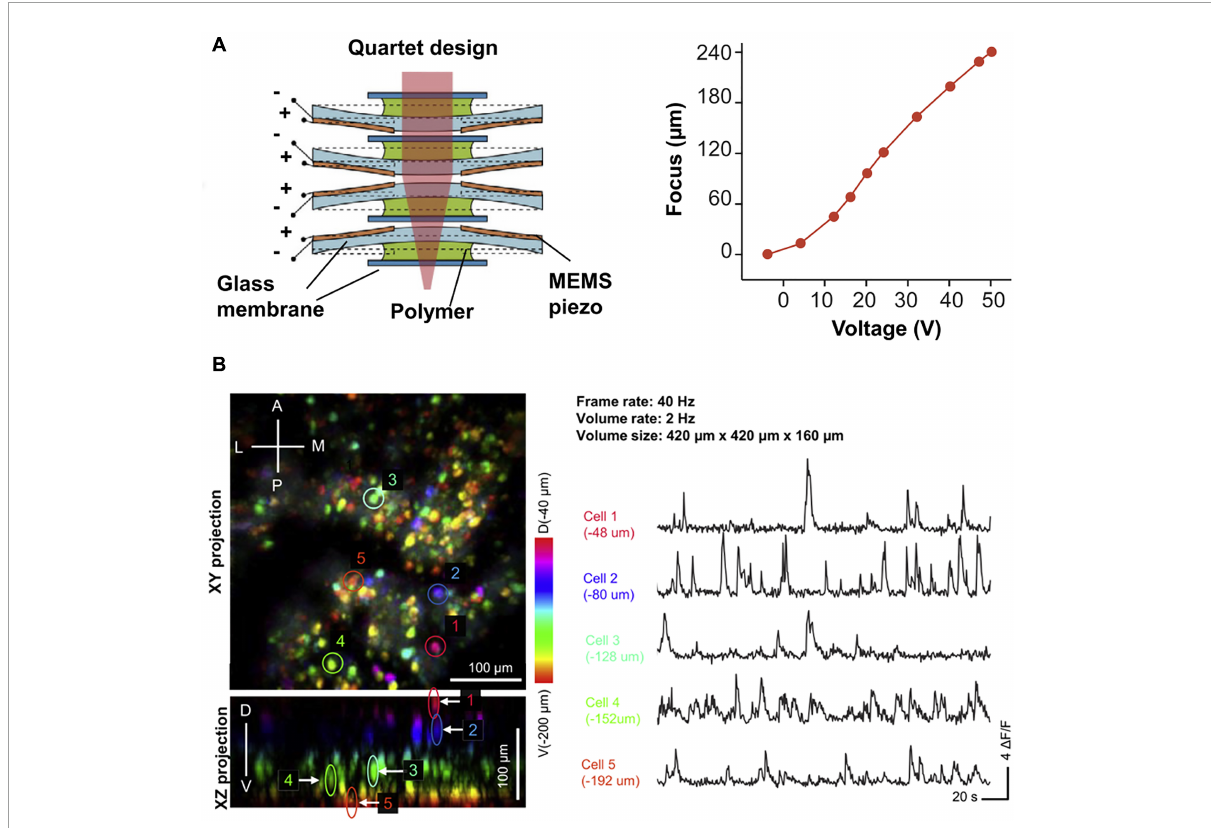
FIGURE7 (A) Design and axial scanning range of µ Tlens (a nanotech micro-tunable lens), which is of only 0.06 g and has a response time of less than 0.4 ms. (B) 3D imaging of VC neurons in freely moving mice, at a volume rate of 2 Hz. Color indicates imaging depth. Reproduced with permission from Zong et al.